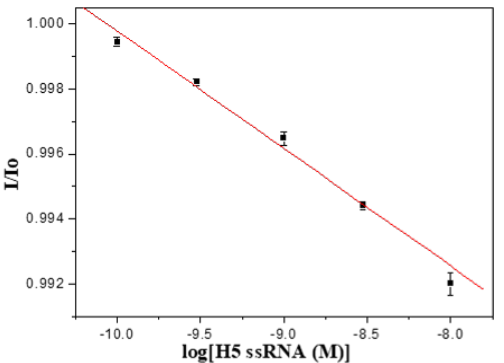
Figure 8. A calibration plot of H5- 3’ s sDNA probe to detect 138-mer target ssRNA, ranging from